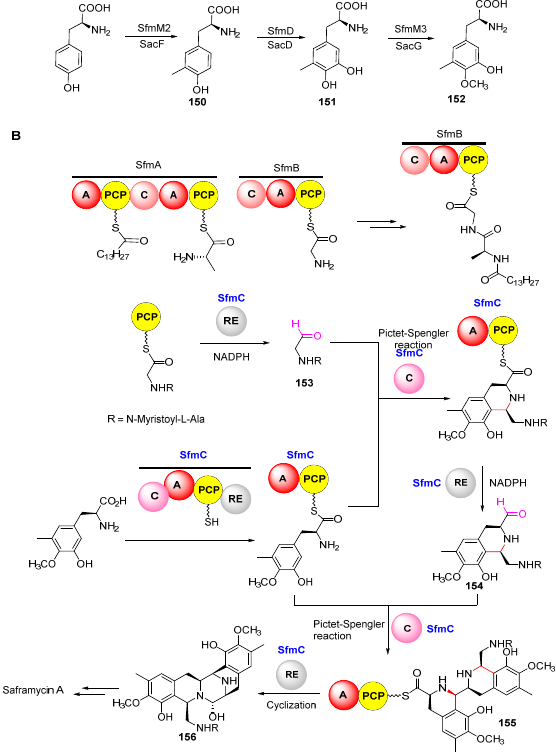
Figure 19. Proposed biosynthetic pathway of quinone moiety ( A ) and forming the skeleton of saframycins ( B ).